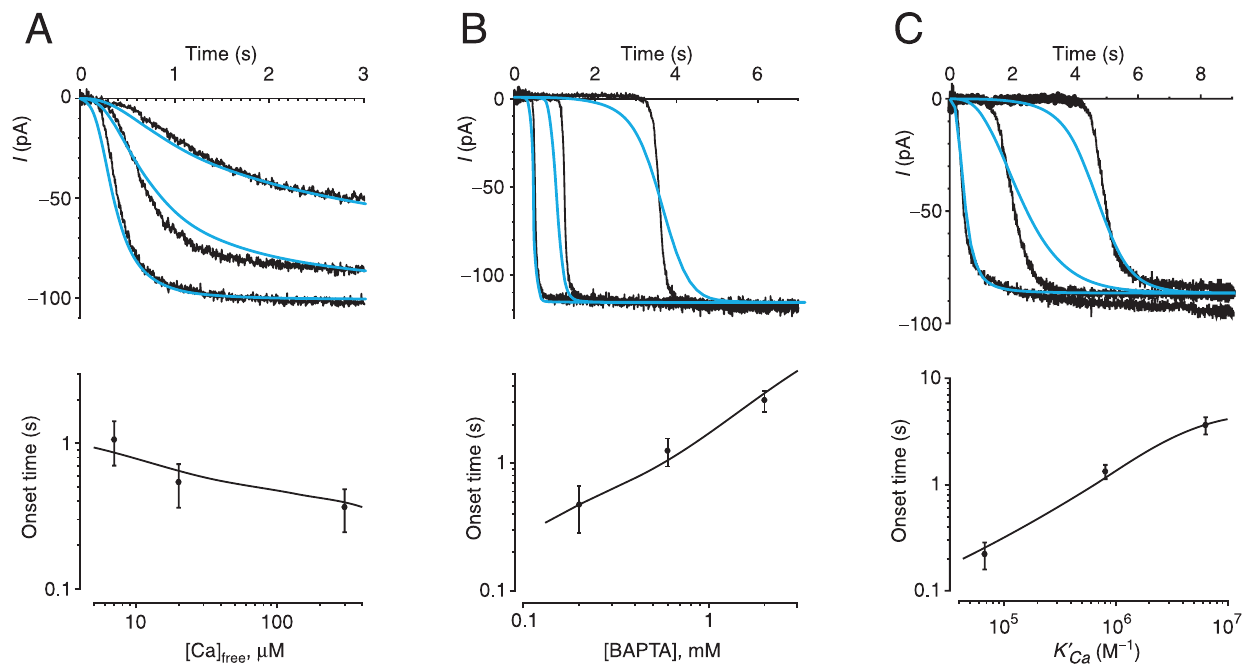
Figure 4. Effects of Ca 2 + -buffering parameters on the observed and predicted Cl 2 currents. (A) The upper figure shows recordings made after a single 30- m m-long cilium was placed in a bath containing 300, 20, or 7 m M free Ca 2 + . All solutions contained 2 mM HEDTA, and pipette potential was clamped at 2 50 mV. The onset times were 241 ms (300 m M free Ca 2 + ), 367 ms (20 m M), and 564 ms (7 m M). The three blue curves are the currents predicted by the forward model assuming that 3800 Cl 2 channels were present in a narrow band centered 11.5 m m from the base of the cilium. In the lower figure, the points show the experimental relation between [Ca 2 + ] free and onset time (means determined in 4 cilia). The line shows the relation predicted by the forward model for a 60- m m-long cilium with a band of channels centered 17.3 m m from the base. (B) The upper figure shows recordings made after a single 40- m m-long cilium was placed in a bath containing 0.2, 0.6, or 2 mM BAPTA. All solutions contained 300 m M free Ca 2 + , and pipette potential was clamped at 2 50 mV. The onset times were 450 ms (0.2 mM BAPTA), 1.17 s (0.6 mM), and 3.39 s (2 mM). The three blue curves are the currents predicted by the forward model assuming that 4960 Cl 2 channels were present in a narrow band centered 12.2 m m from the base of the cilium. In the lower figure, the points show the experimental relation between [BAPTA] and onset time (means determined in 8 to 12 cilia). The line shows the relation predicted by the forward model for a 50- m m-long cilium with a band of channels centered 14 m m from the base. (C) The upper figure shows recordings made after a single 68- m m-long cilium was placed in a bath buffered with HEDTA, dibromoBAPTA, or BAPTA. In all solutions, [Ca 2 + ] free was 300 m M and [buffer] was 2 mM. Pipette potential was clamped at 2 40 mV. The onset times were 255 ms (HEDTA), 1.48 s (dibromoBAPTA), and 4.50 s (BAPTA). The three blue curves are the currents predicted by the forward model assuming that 4720 Cl 2 channels were present in a narrow band centered 13.5 m m from the base of the cilium. In the lower figure, the points show the experimental relation between the buffer’s apparent association constant for Ca 2 + ( K 9 Ca ) and onset time (means determined in 13 to 21 cilia). The line shows the relation predicted by the forward model for a 50- m m-long cilium with a band of channels centered 13.8 m m from the base. From each recording shown in the upper figures, a small leak current ( 2 9 to 2 15 pA) has been